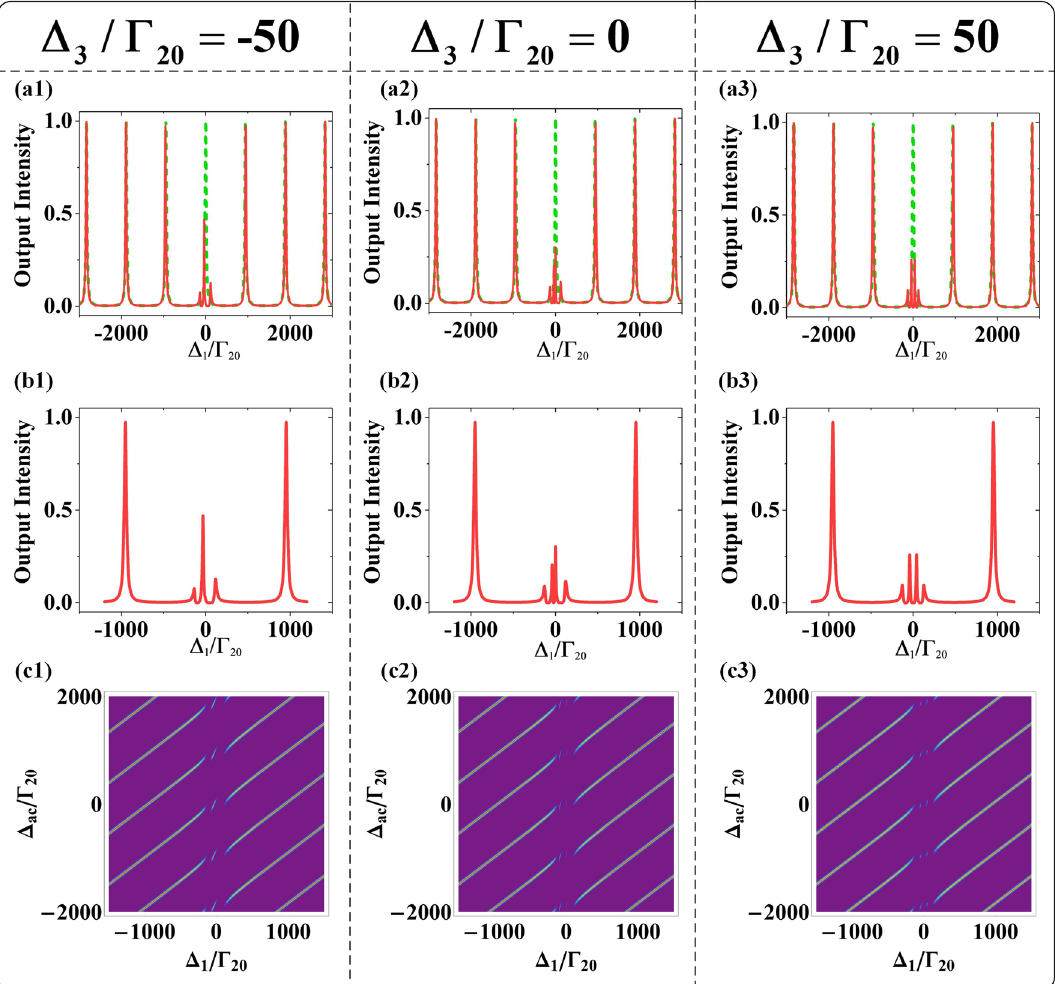
50 . ( a2 ) With � 3 /Ŵ 20 0 . ( a3 ) = − =